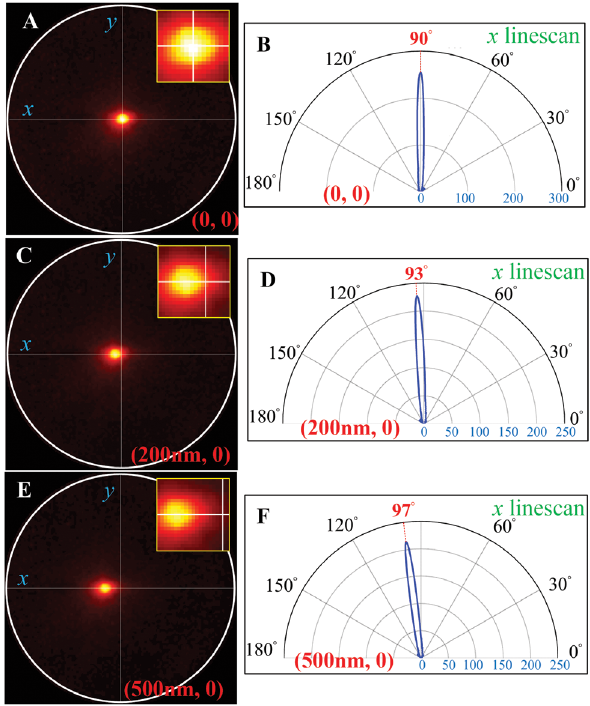
Figure 11 Fluorescence intensity distributions for different dis- placements of the feed point. For zero displacement: (A) intensity distribution, (B) line-scan in the x-z plane. For a displacement of 200 nm and 500 nm along the x axis: (C, E) intensity distribution, (D, F) line-scans in the x-z plane. Adapted from Ref.